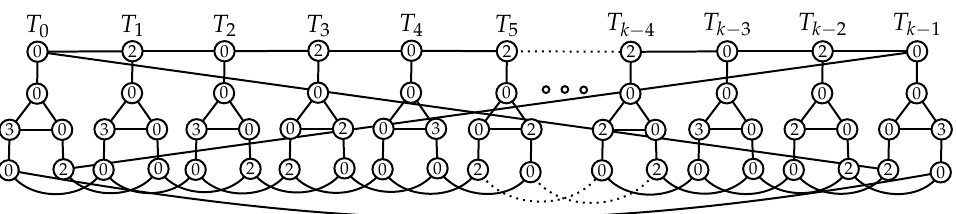
Figure 3. A DRDF of P ( 3 k , k ) with k = 6 (cid:96) +